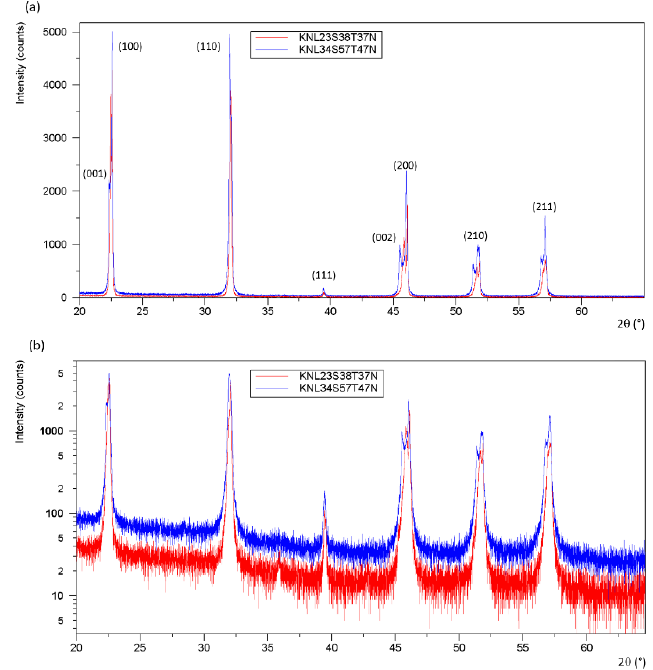
Figure 7. Cont . Figure 7. Cont .